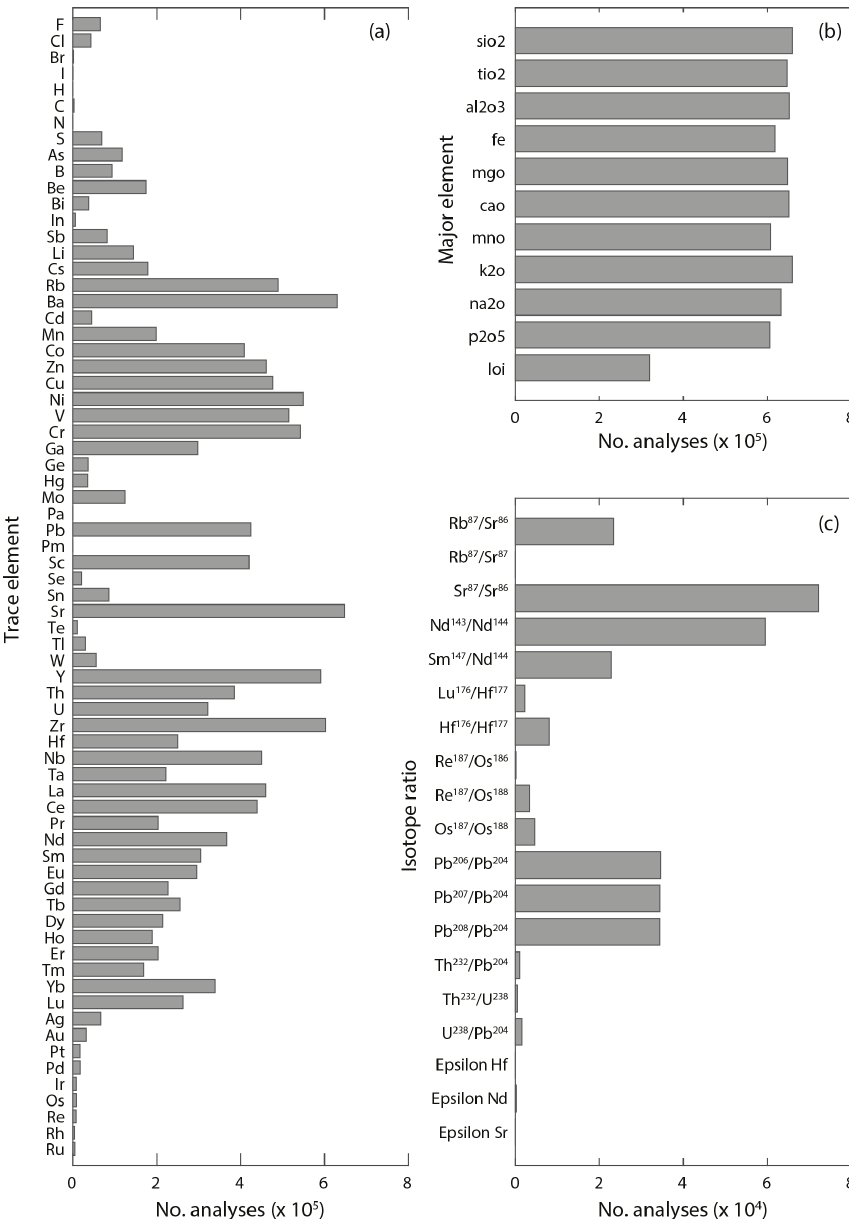
Figure 2. Histogram of analyses. (a) Trace elements. (b) Major oxides. Fe denotes any one or more entries for feo, feo total, fe2o3, or fe2o3 total. (c) Isotope ratios and epsilon